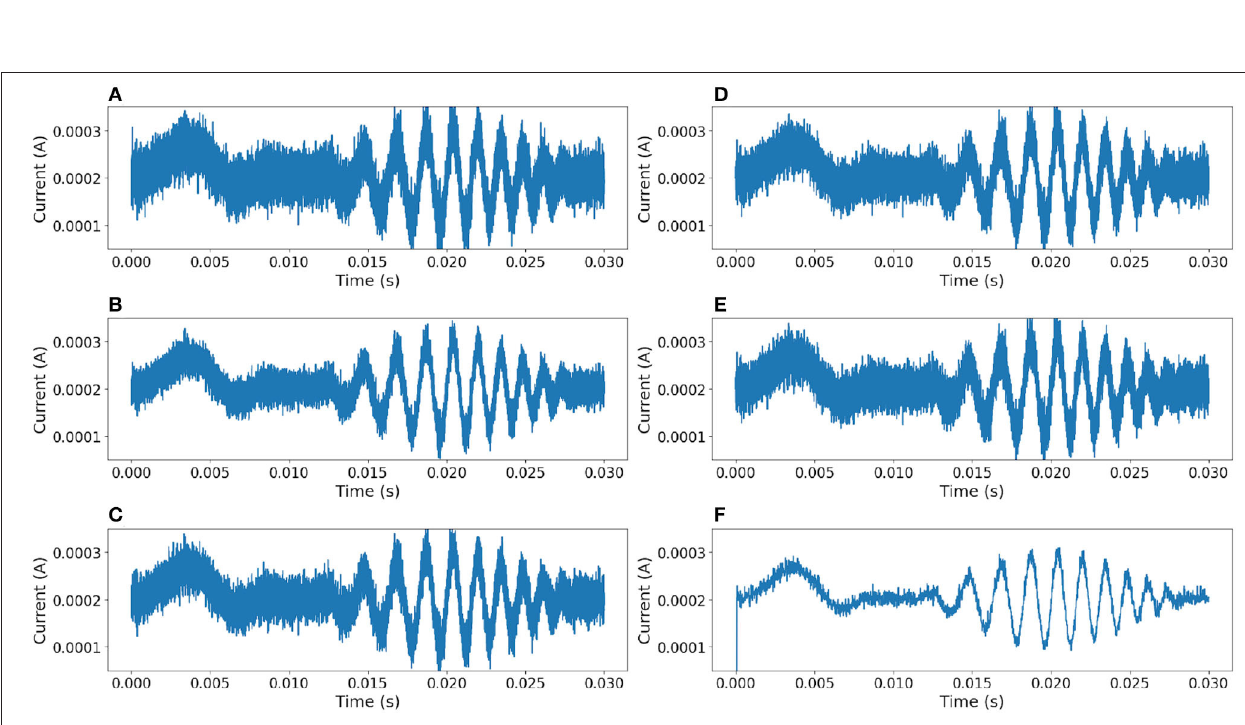
FIGURE 10 | Comparison of results between different filters. (A) Median filter. (B) 3rd-order Chebyshev type 1 filter with cutoff frequency at 55 kHz . (C) 3rd-order Chebyshev type 2 filter with cutoff frequency at 55 kHz . (D) 3rd-order Butterworth filter with cutoff frequency at 55 kHz . (E) 3rd-order Elliptic filter with cutoff frequency at 55 kHz . (F) Neural filter